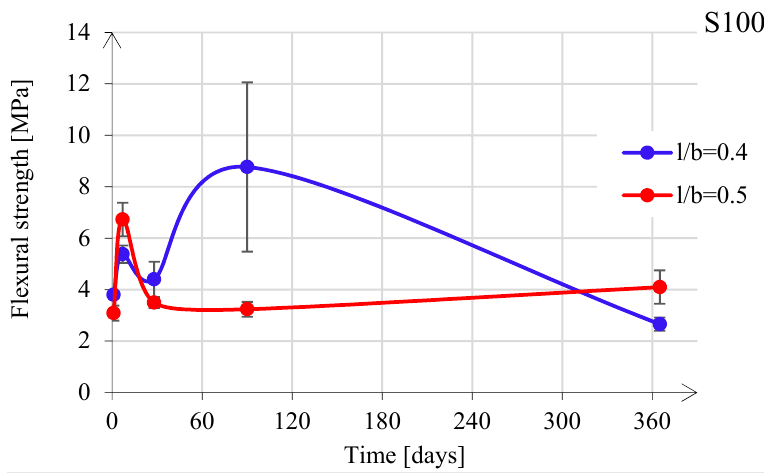
Figure 13. Flexural strength development for S100 paste.